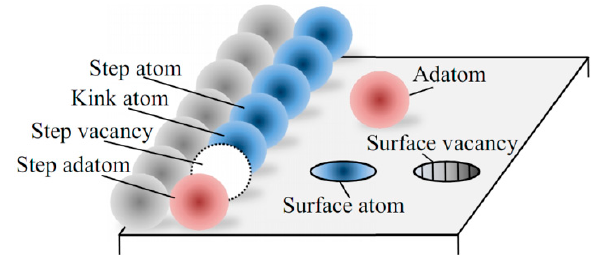
Figure 1. Diagram showing the flow of adatoms during formation of a coating.